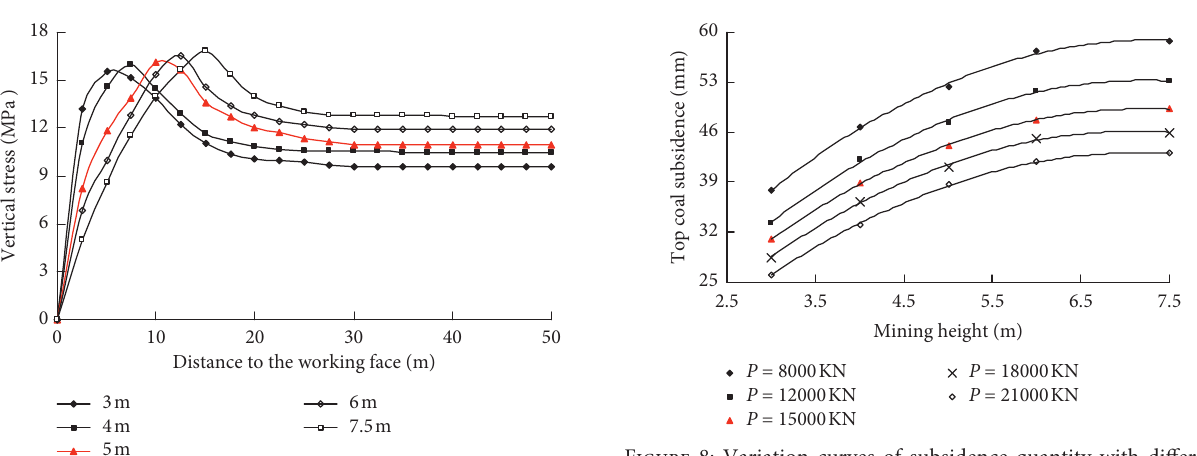
Figure 6: Vertical stress distribution for different mining height.